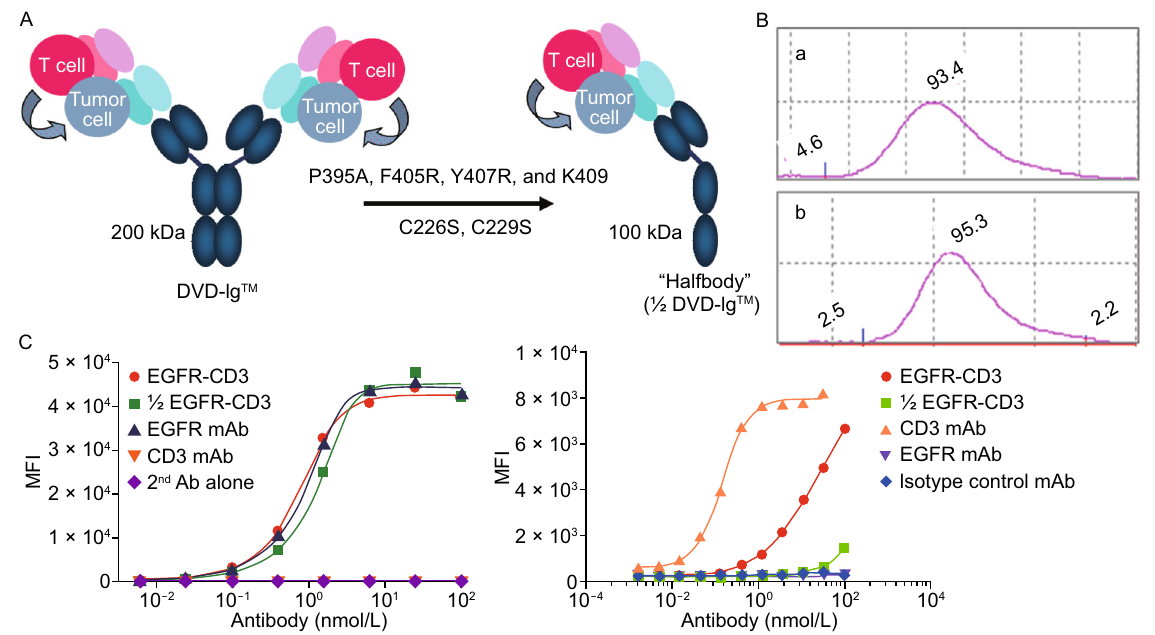
Figure 2. Half DVD-Ig design and characterization. (A) Mutagenesis at C H 3 and hinge region converted anti-EGFR/anti-CD3 DVD-Ig into a Half DVD-Ig molecule. (B) (a) Intact anti-EGFR/anti-CD3, shown for comparison, and (b) Half DVD-Ig protein can be produced and puri fi ed to homogeneity with approximate 95% monomer percentage analyzed by size exclusion chromatography. (C) Binding of Half DVD-Ig to EGFR on A431 cells (left) and CD3 on Jurkat cells